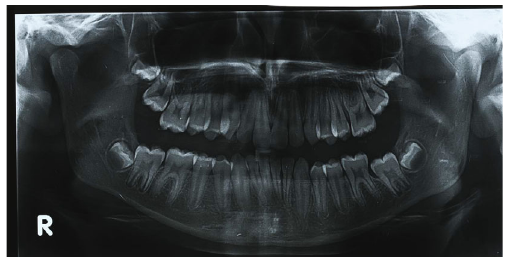
Figure 3: Pretreatment